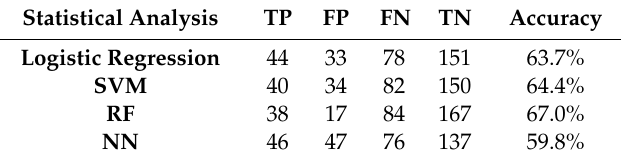
Table 2. Prognostic accuracy with each predictive model.